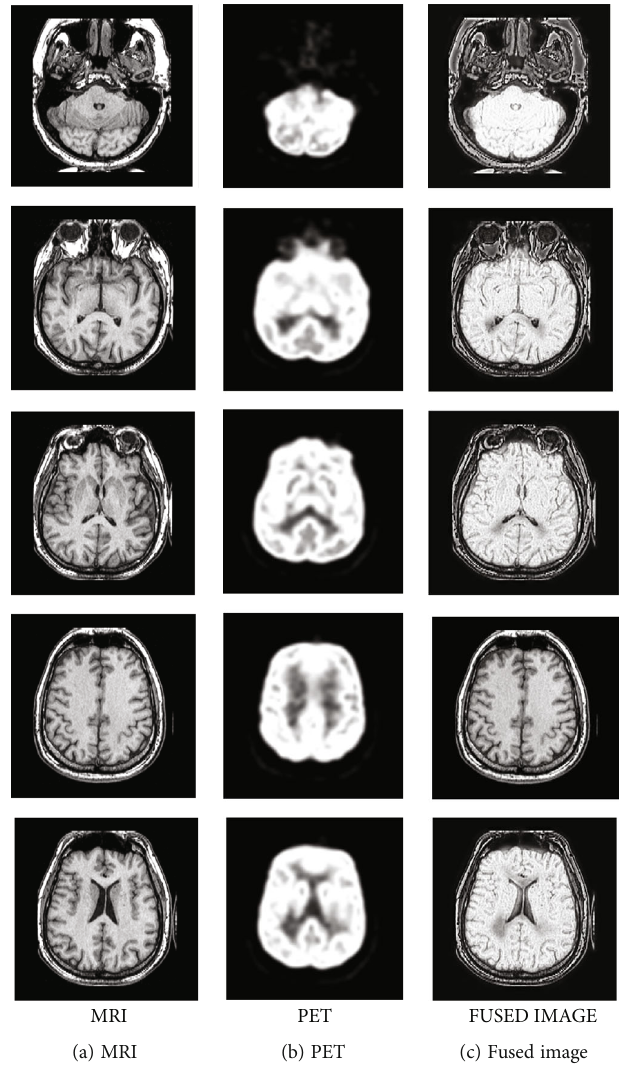
Figure 9: Result obtained from the proposed